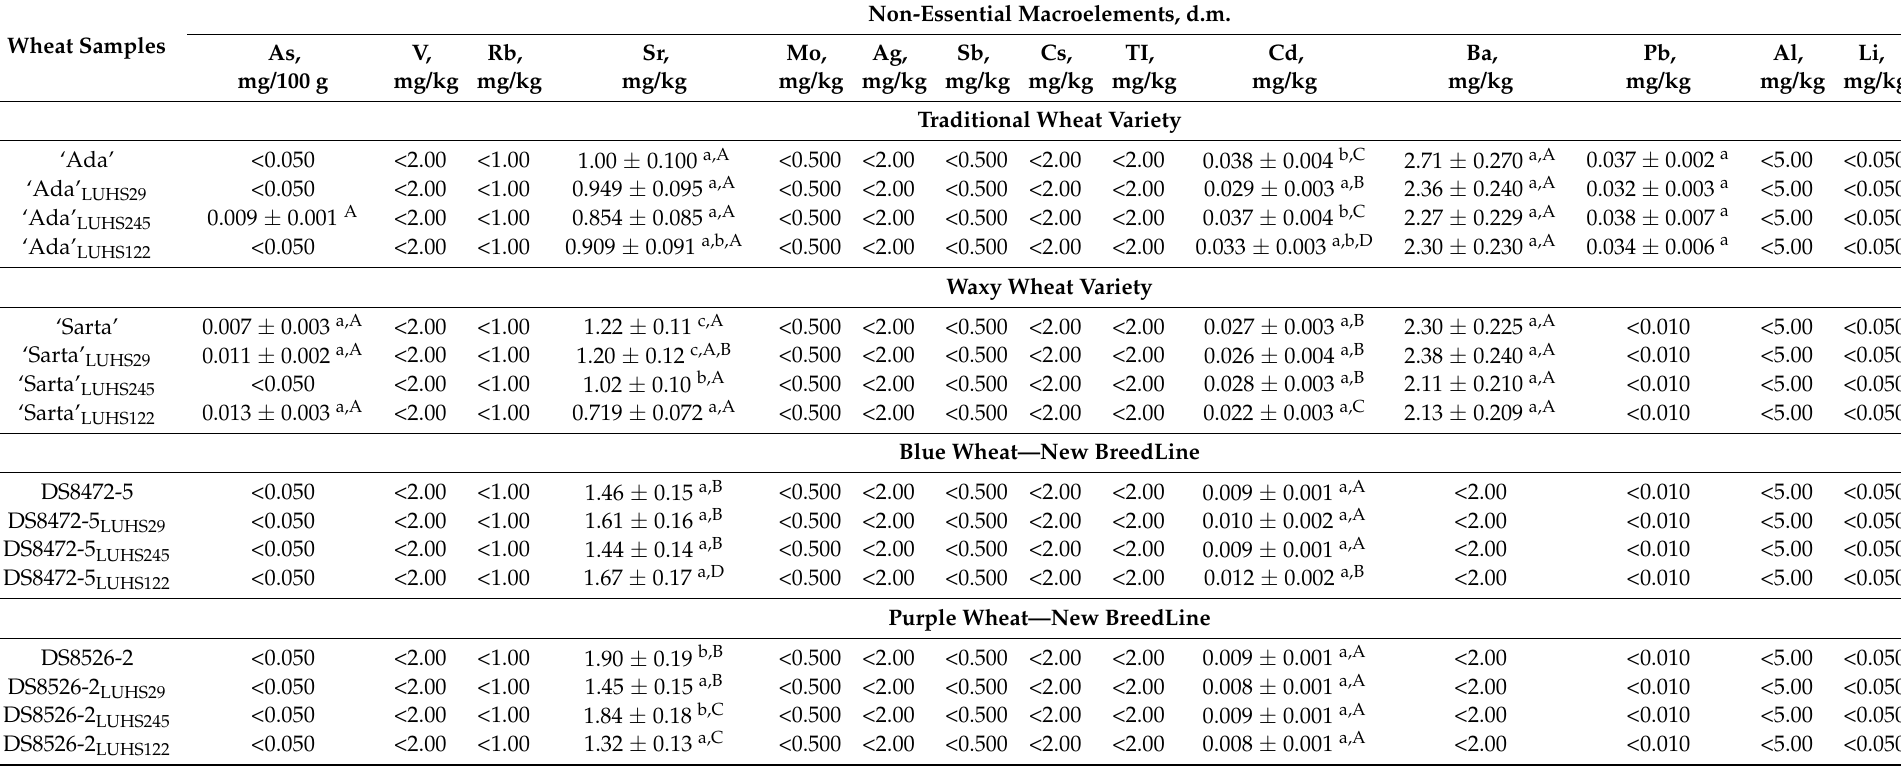
Table 5. Non-essential microelement concentrations in wheat wholemeal